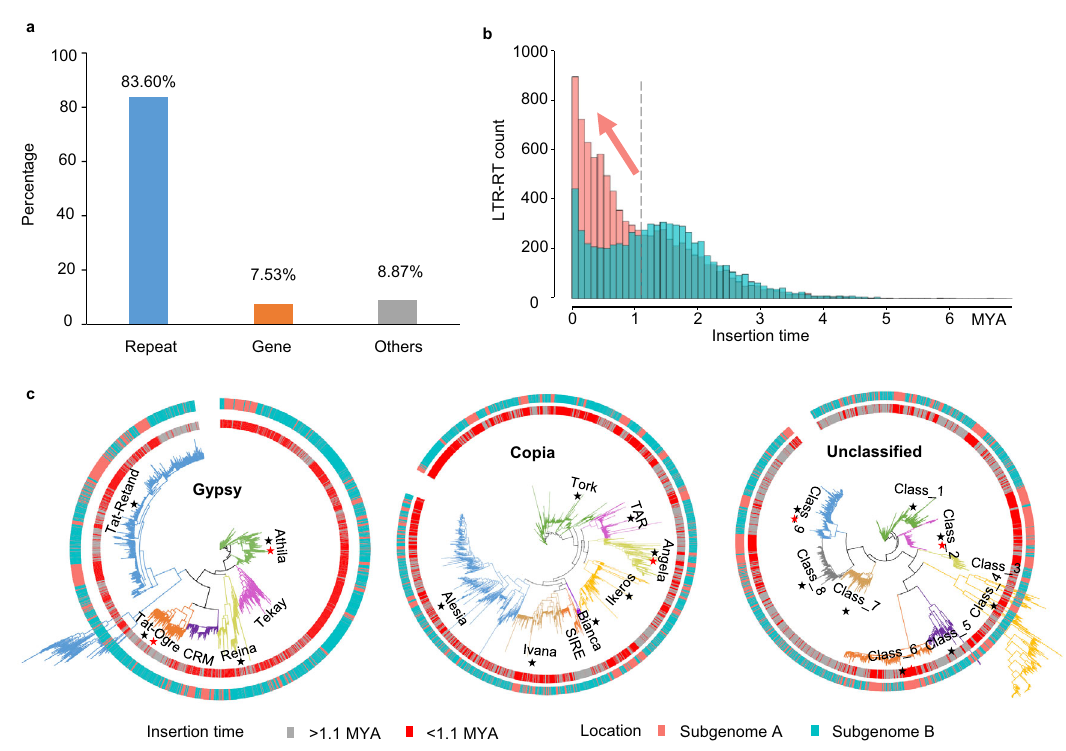
Fig. 4 The subgenomes A and B diverged mainly by insertion of long terminal repeat-retrotransposons (LTR-RT) on subgenome A. a Composition of different genomic features in the patchouli genome. b Histogram of the insertion time of full-length LTR-RTs in subgenomes A and B. c Lineage classi fi cation of LTR-RT superfamilies. The subgenome location and insertion time of Copia, Gypsy, and Unclassi fi ed LTR-RTs are indicated by the outer and inner circles, respectively. Red stars and black stars denote the lineages whose length and count expanded in subgenome A after 1.1 million years ago (MYA),